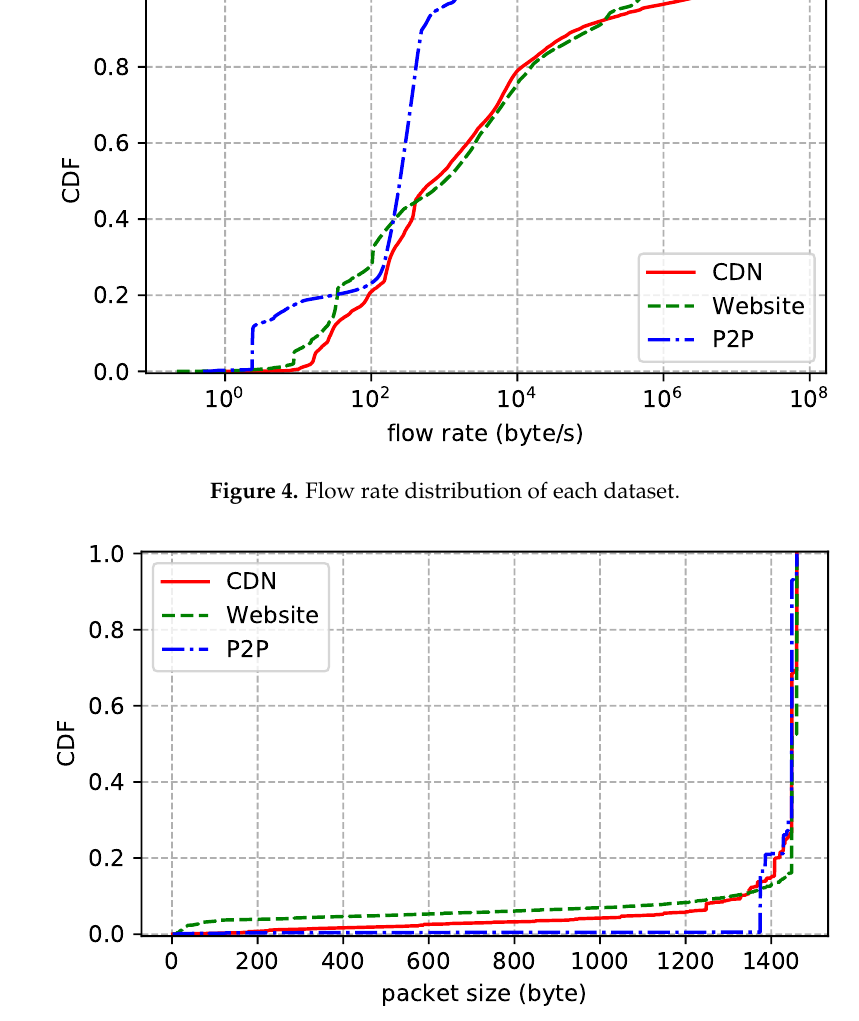
Figure 5. Packet size (payload) distribution of each